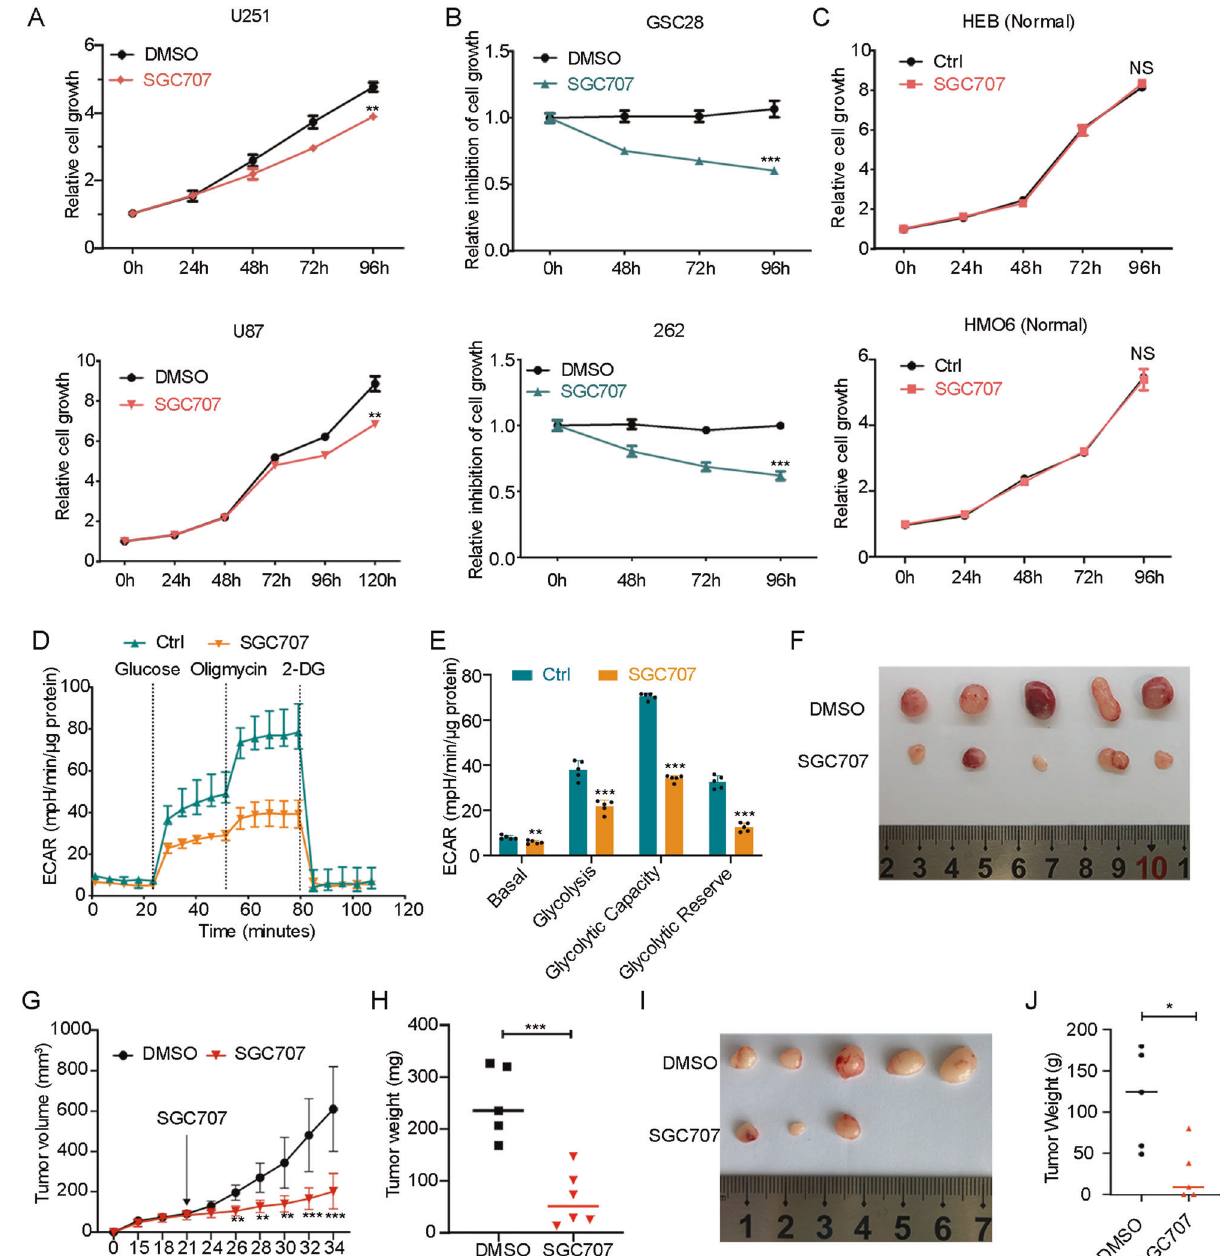
Fig. 8 Pharmacological Inhibition of PRMT3 Decreases GBM growth. A Growth of U251 and U87 cells treated with SGC707 (10 μ M) at the indicated times after treatment initiation. n = 3 independent assays. B Growth inhibition of GSC28 and GSC262 cells treated with SGC707 (10 μ M) at the indicated times after treatment initiation. n = 3 independent assays. C Growth of HEB and HMO6 normal brain cells treated with SGC707 (10 μ M) at the indicated times after treatment initiation. n = 3 independent assays. D , E ECAR of GSC262 cells after treatment with SGC707 for 72 h ( D ) and quanti fi cation ( E ). n = 5 independent assays. F Photomicrographs of tumors formed in the fl anks of nude mice injected with GSC262 cells that were treated with DMSO or SGC707. G Volumes of tumors formed in the fl anks of nude mice injected with GSC262 cells that were treated with DMSO or SGC707. Arrow: treatment starting date. n = 5 or 6 animals/group. H Weights of tumors formed in the fl anks of nude mice injected with GSC262 cells that were treated with DMSO or SGC707. n = 5 or 6 animals/group. I Photomicrographs of tumors formed in the fl anks of nude mice injected with GSC20 cells that were treated with DMSO or SGC707. J Weights of tumors formed in the fl anks of nude mice injected with GSC20 cells that were treated with DMSO or SGC707. n = 5 animals/group. Data are presented as means ± SEM; * p < 0.05, ** p < 0.01; *** p < 0.001; two-tailed unpaired Student t-test. N.S., not signi fi